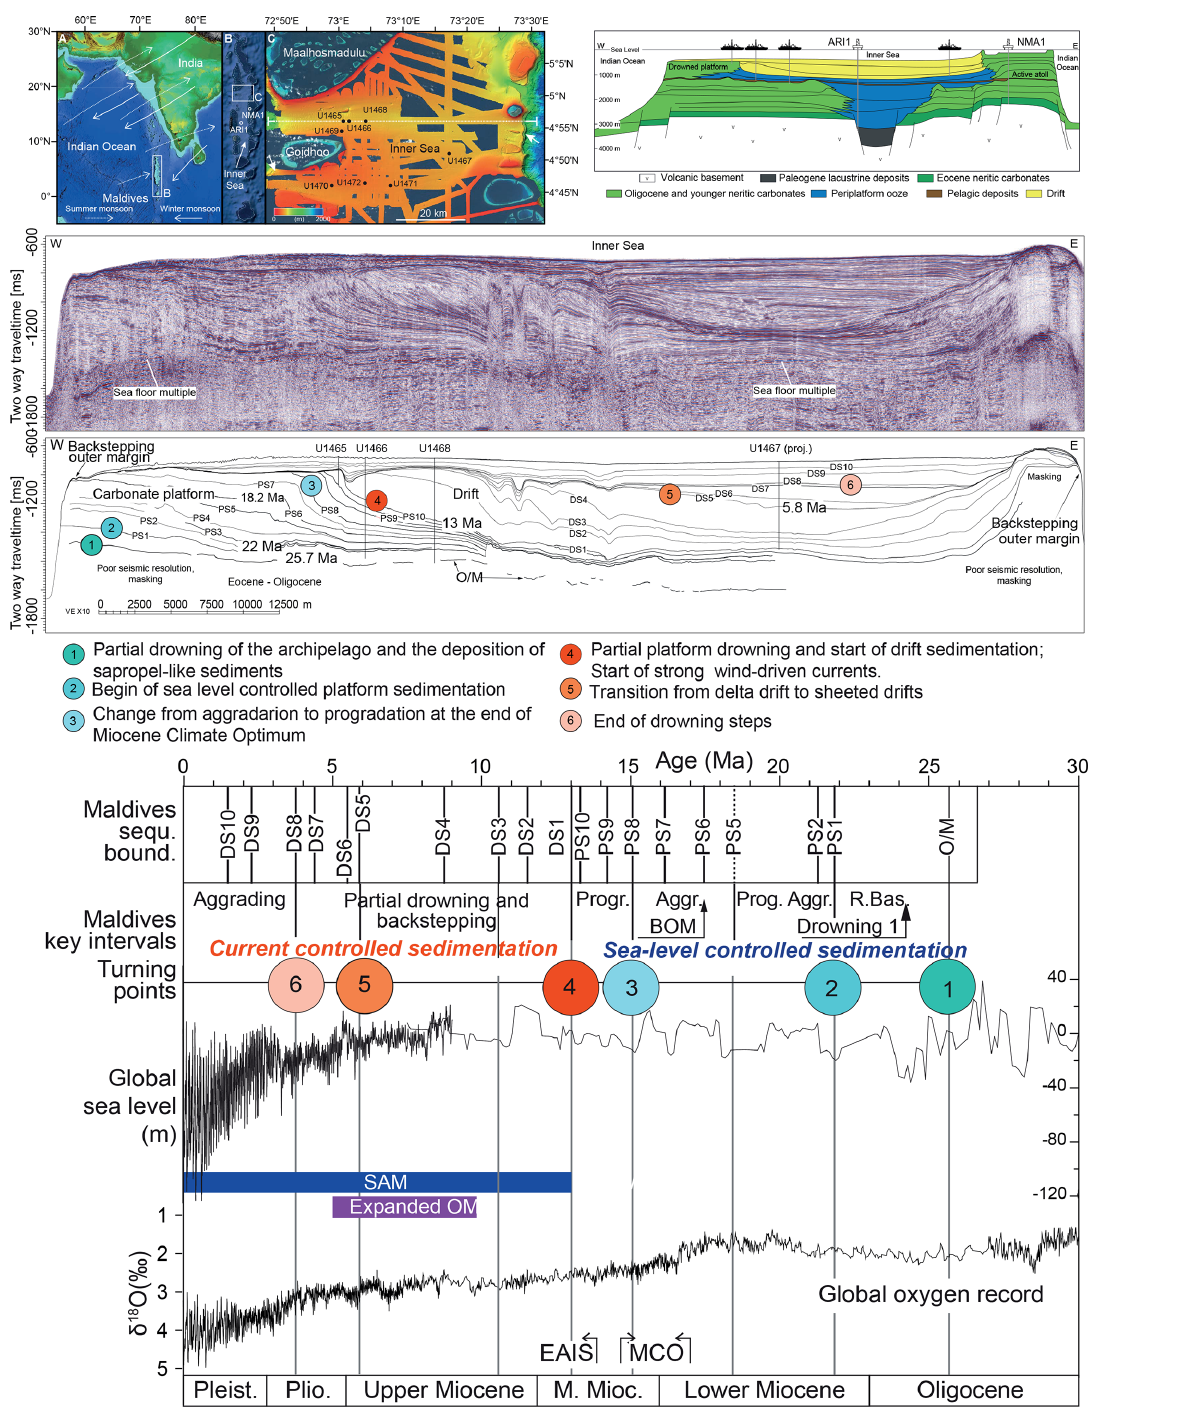
Figure 3. The Maldives archipelago, located in the Indian Ocean, is affected by the seasonally reversing monsoonal winds and currents. The archipelago has two rows of drowned and active atolls that line the Inner Sea. Seismic line across the Maldives Inner Sea with line drawing showing the platform sequence (PS) boundaries and the drift sequence (DS) boundaries. Carbonate platform sedimentation is controlled by sea level, while the drift sequences are controlled by strong currents which start at 13Ma. Major turning points in sea level (blue circles) and current control (reddish circles) are indicated. Position of seismic line corresponds to white line in the map. Maps were produced using the program Esri ArcMap 10.1 (http://www.esri.com, last access: 29 May 2022). Bathymetric data were exported as Geotiffs from GeoMapApp 3.6.0 (http://www.geomapapp.org, last access: 29 May 2022). Worldwind satellite images (http://worldwind.arc.nasa.gov/java, last access: 29 May 2022) were merged with multibeam data acquired during cruises M74/4 and SO236.